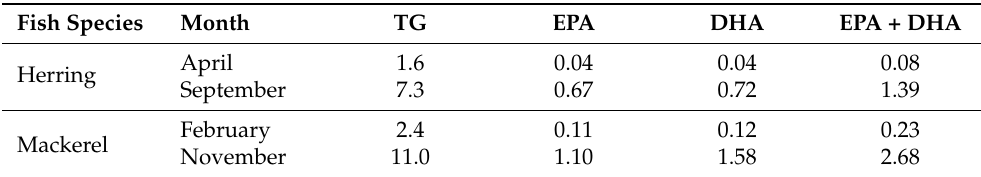
Table 1. Content of TG, EPA and DHA in TG (g/100 g) of fresh coldwater fish from the North Atlantic (region near Newfoundland) during different seasons.